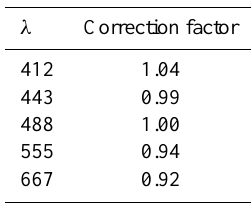
Table A1. Correction factors to convert SeaWiFS- R rs (λ) into MODIS- R rs (λ)